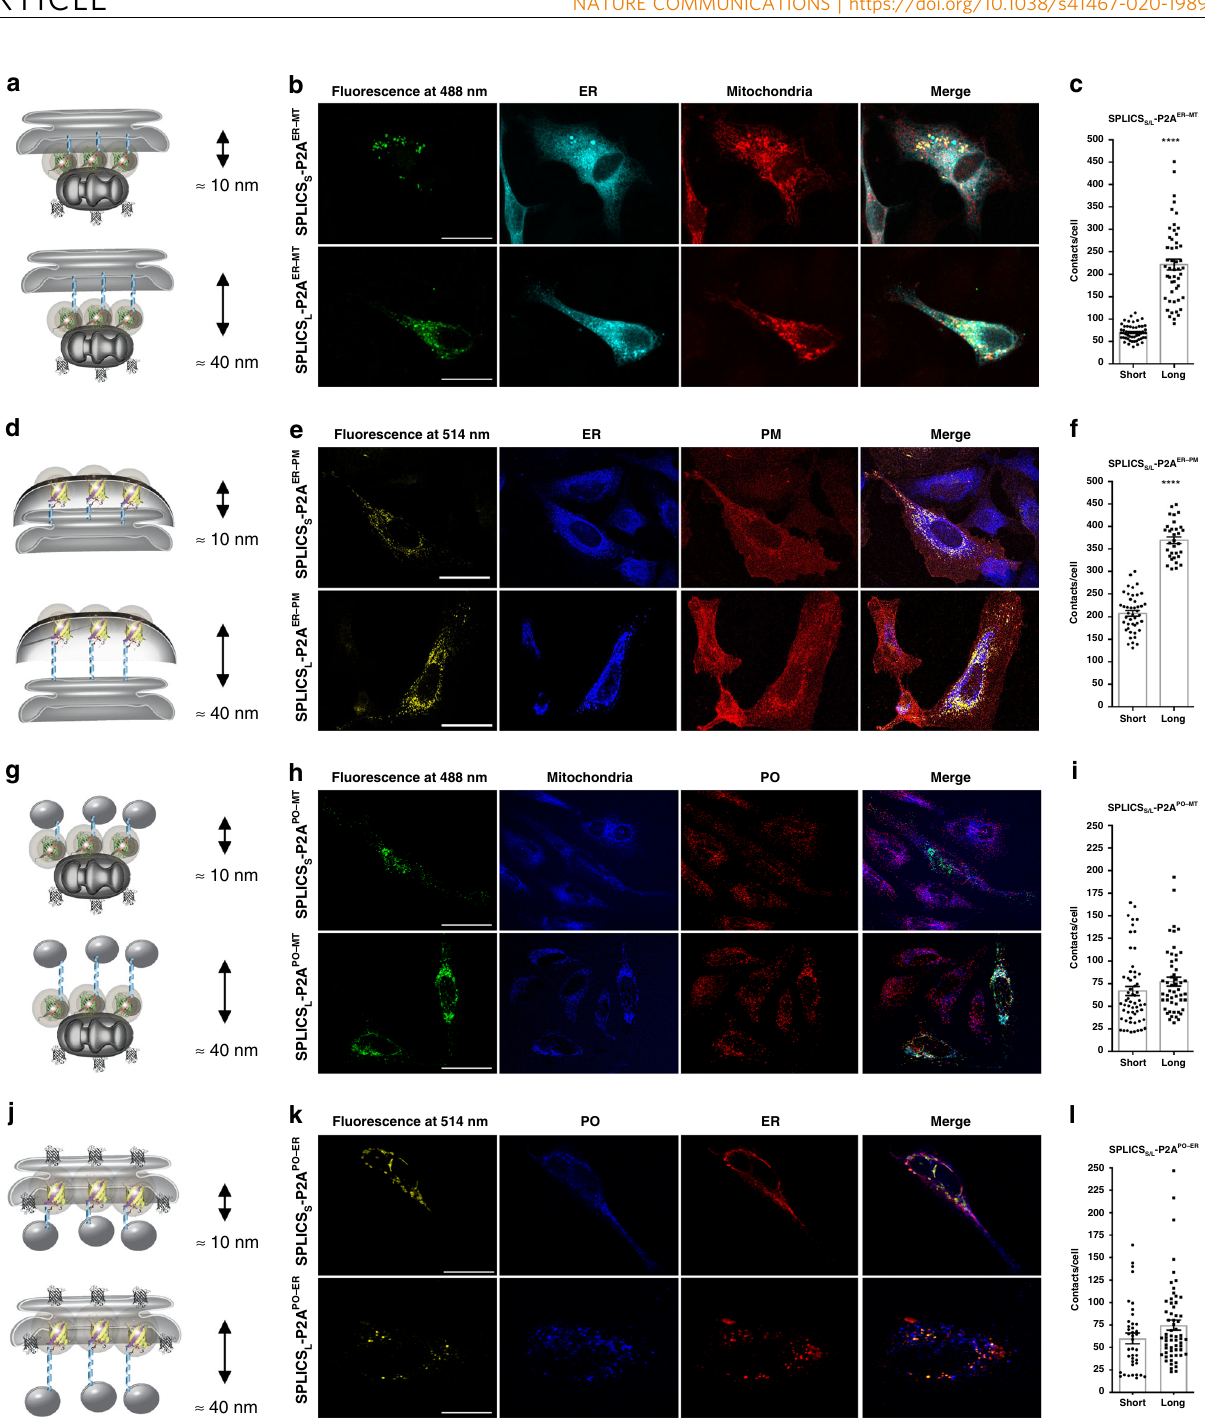
Fig. 2 Functional characterization of the SPLICS S/L -P2A probes. a , d , g , j Cartoon showing the short- and long-range contact sites measured by the indicated reporters. b , e , h , k Representative images of HeLa cells expressing the indicated SPLICS S/L -P2A probes to identify the co-localization of GFP (488 nm) or YFP (514 nm) fl uorescent dots with targeted organelles. Different markers are used to label organelles: red fl uorescent protein (mCherry) targeted to PM, anti-KDEL antibody (ER), mtHSP60 (mitochondria) and anti-PMP70 antibody (PO). Confocal images were acquired at 405, 488, 514, and 588 nm excitation wavelength. Scale bar 25 µ m. c , f , i , l Quanti fi cation of the indicated SPLICS S/L -P2A (short and long) contacts in HeLa cells. The SPLICS dots were quanti fi ed from the 3D rendering of a complete Z-stack (see Supplementary Fig. 2), mean ± SEM. The data were obtained from three independent transfections. (**** P ≤ 0.0001 unpaired two-tailed t -test). Source data are provided as a source data fi